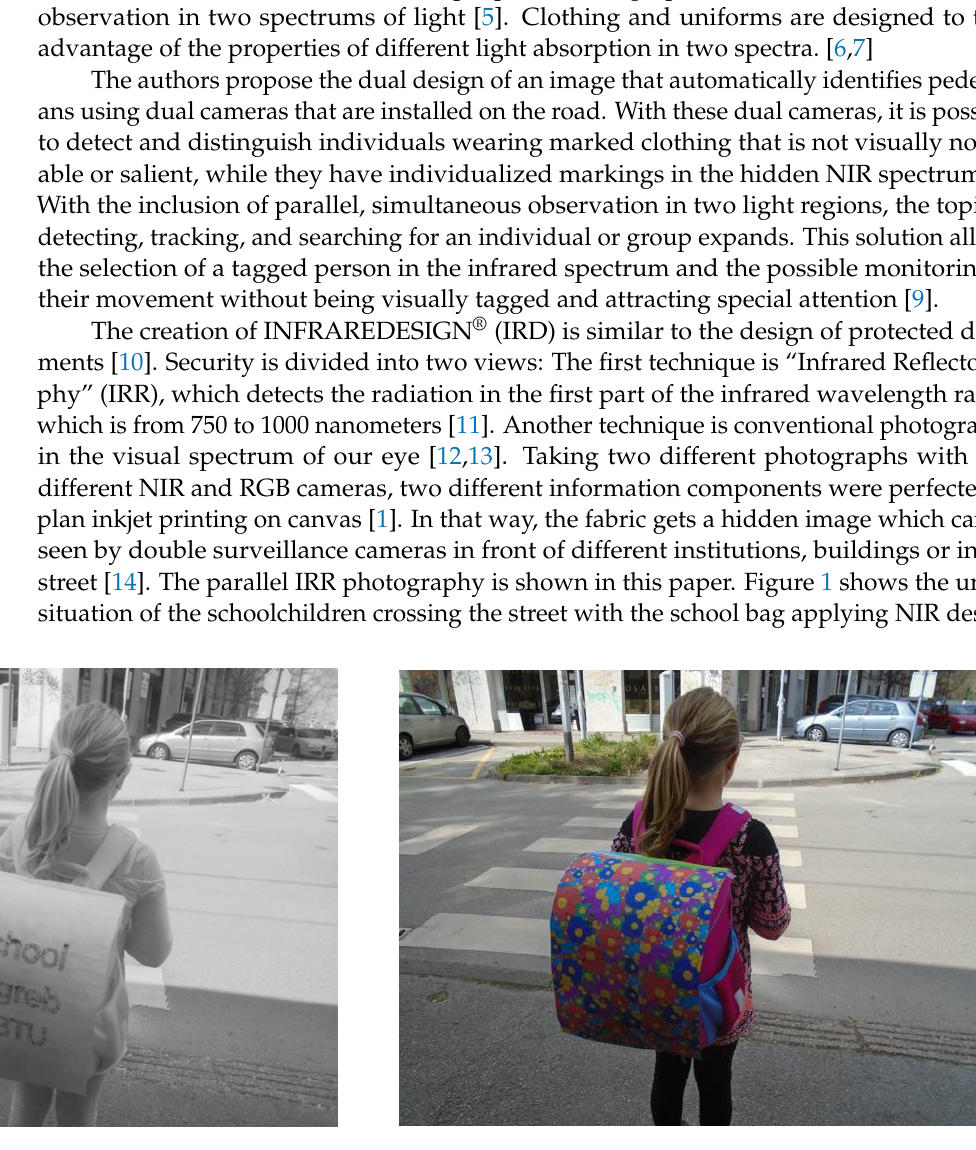
Figure 1. A schoolchild with a bag on her back, photographed with Z and RGB cameras [12,13]. The video of night movement uses its additional source of NIR radiation [9]. The video of night movement uses its additional source of NIR radiation